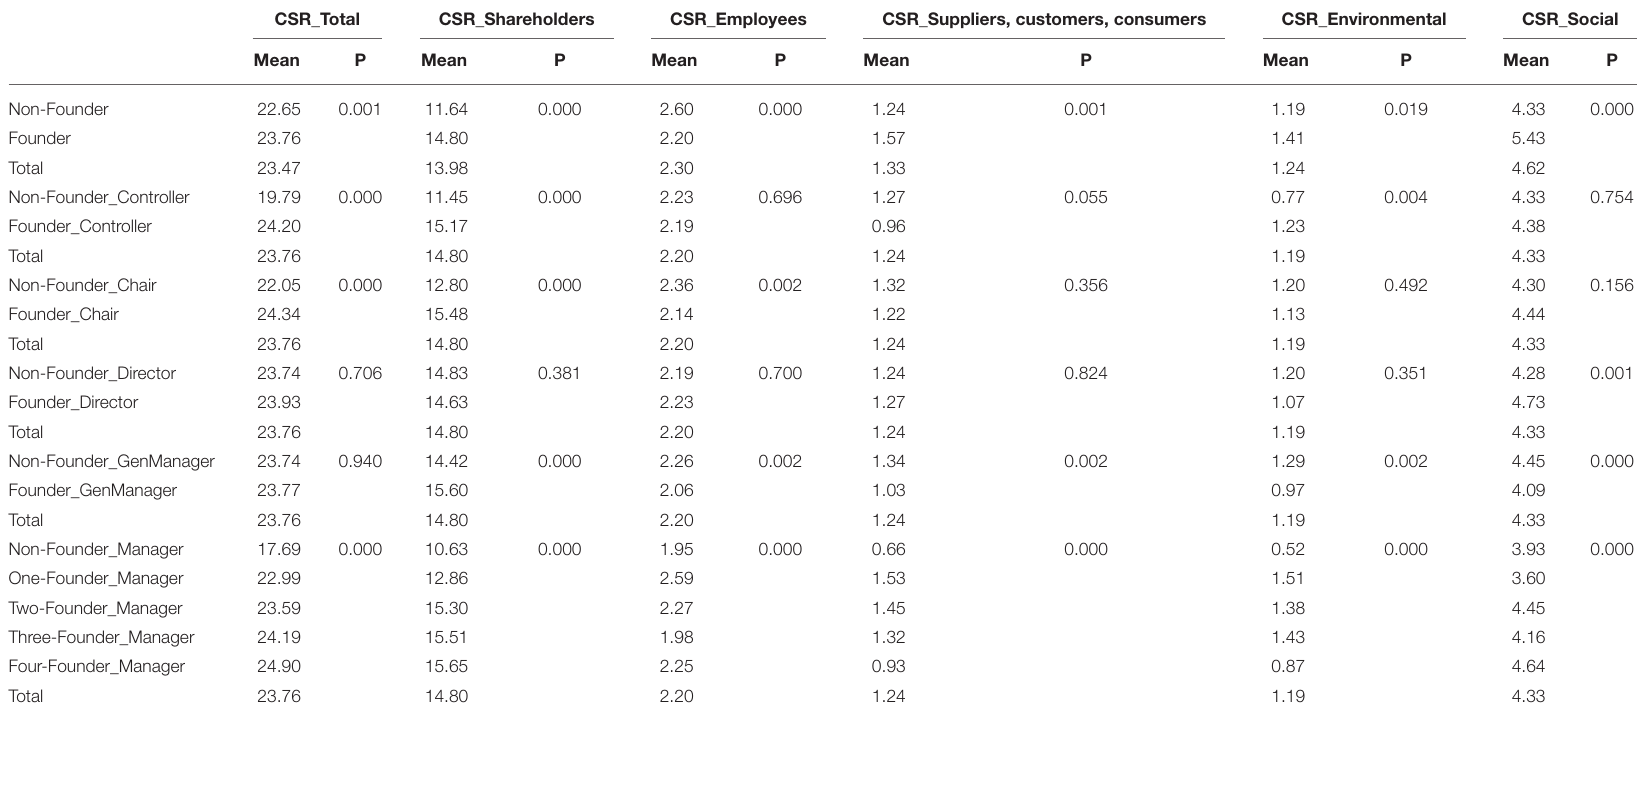
TABLE 6 | ANOVA analysis